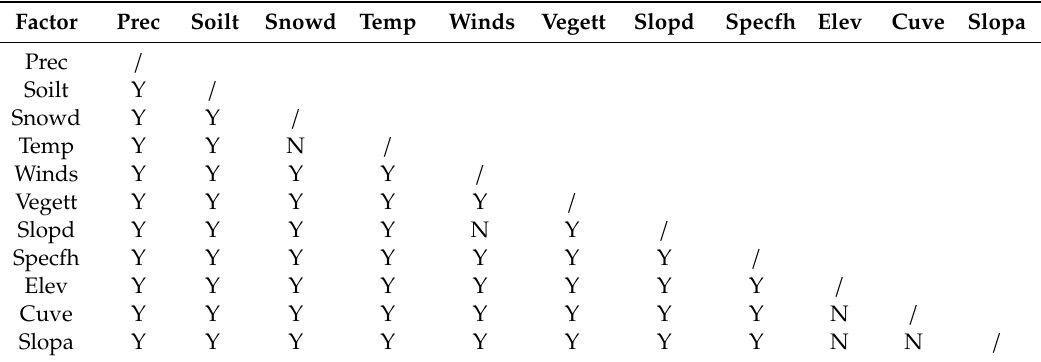
Table 6. Statistical significance of the detection factors (95% confidence